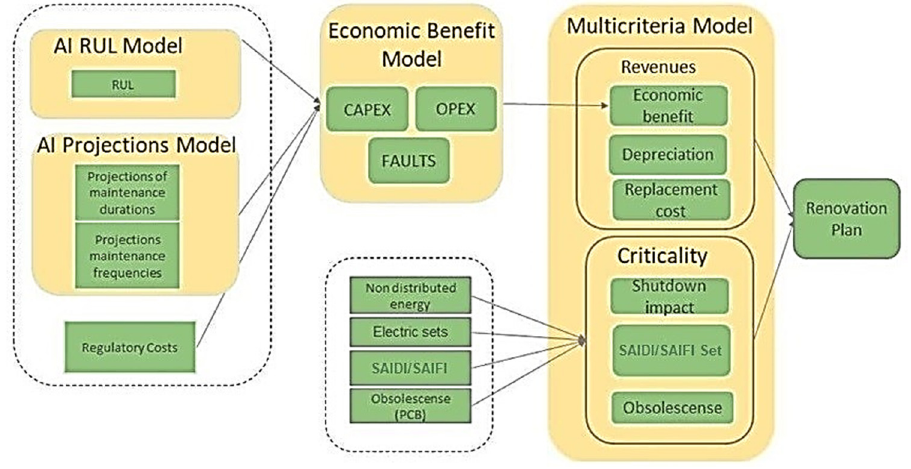
Figure 1. Data flow for the analytical tool FERA [authors].